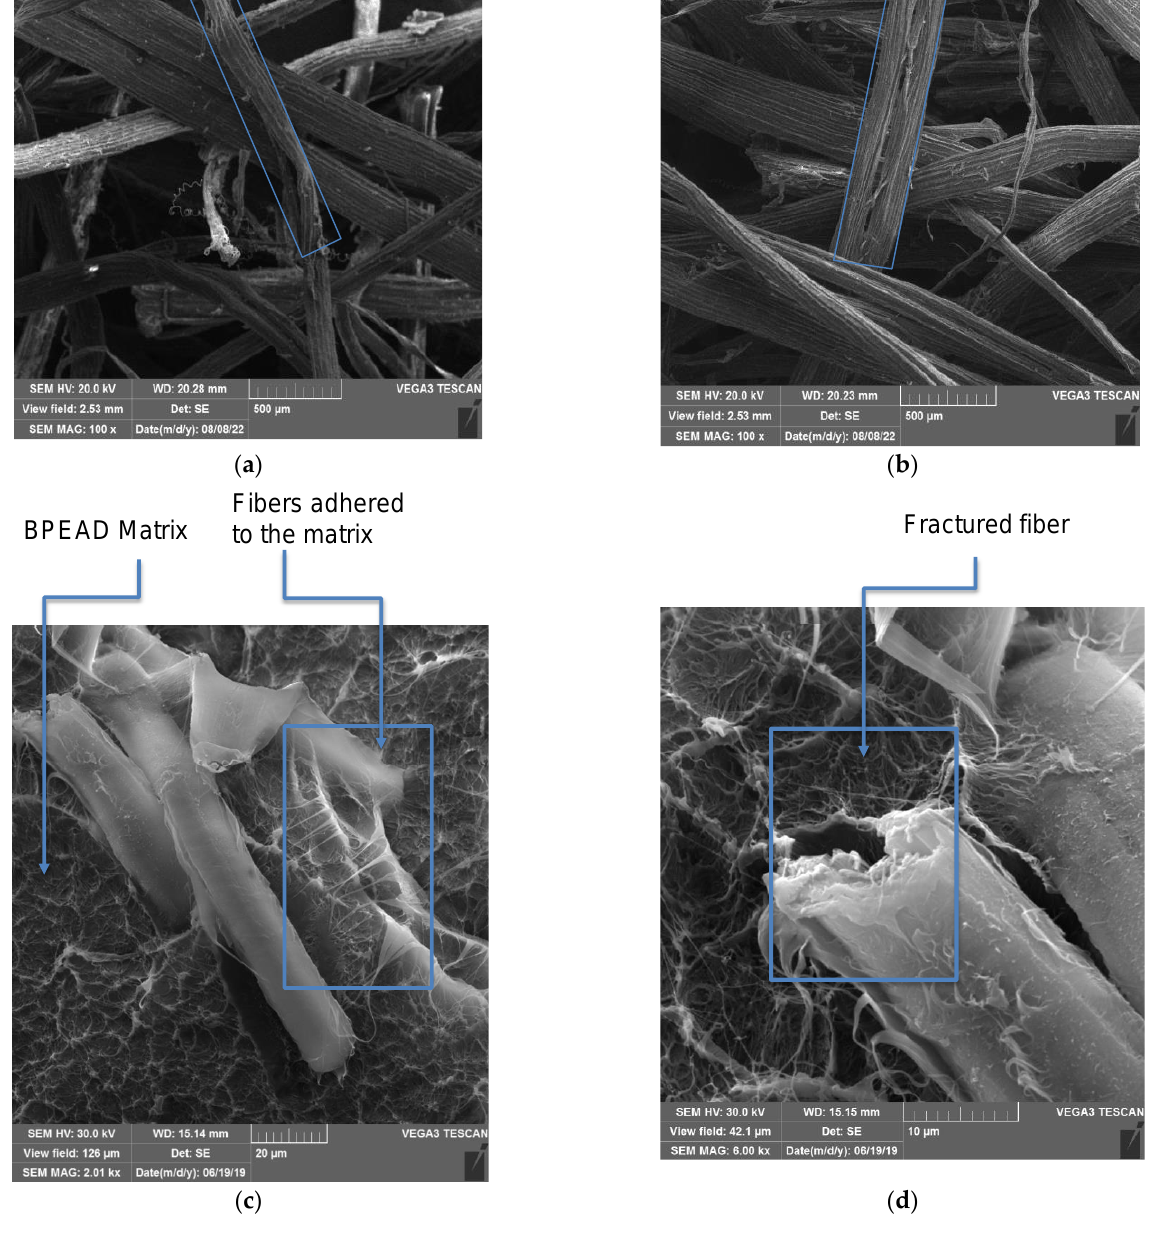
Figure 6. ( a ) SEM micrographs of the curauá fibers without alkaline treatment, ( b ) with alkaline treatment and ( c , d ) B-HDPE/PE-g-MA/CF1 biocomposites.